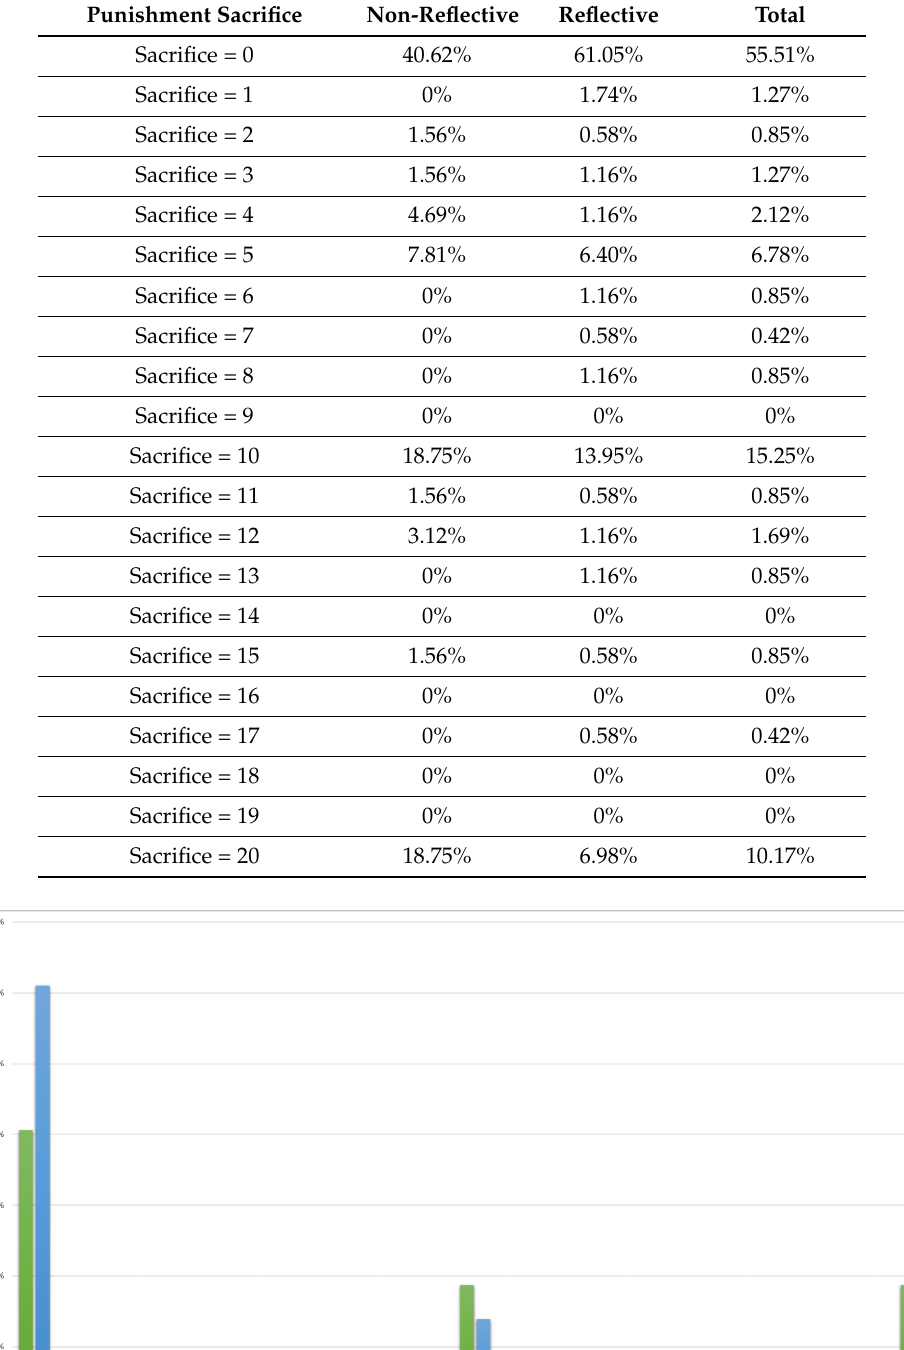
Table A15. Frequency of Punishment Sacrifice by Non-Reflective (Reflective) Individuals.